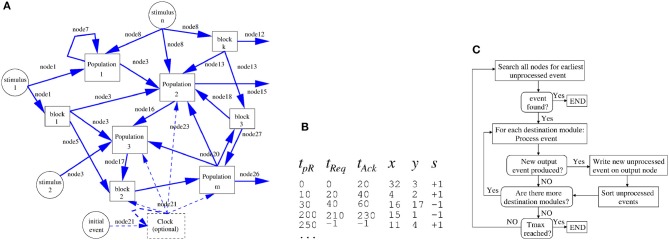
Illustration of generic multi-module/population for MegaSim Event-Driven simulation. (A) Nodes and links, (B) a section of an event list, (C) Megasim's data flow and control diagram.